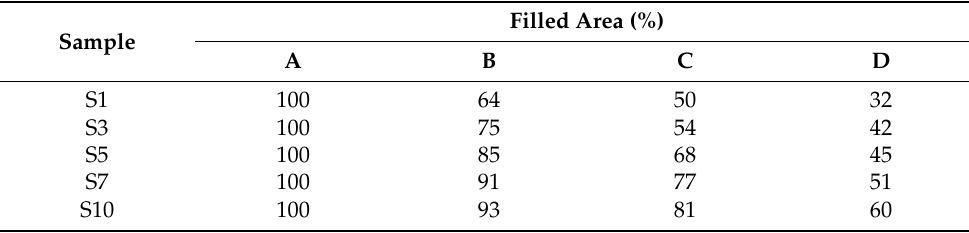
Table 7. The percentage degree of filling of the graphic symbols with the laser beam interference points.